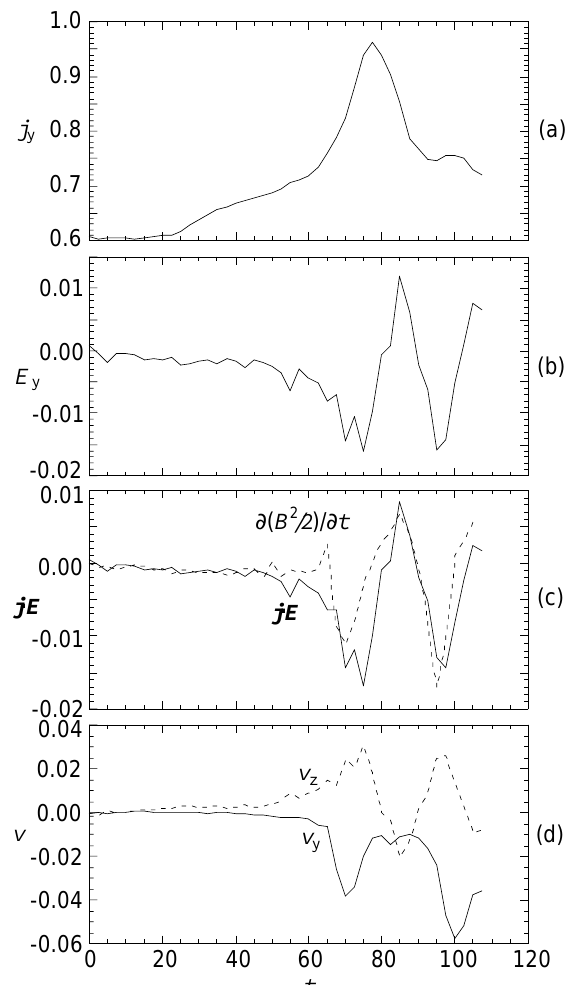
Fig. 9. Characteristic quantities in the generator region at x =− 8 . 75 , y =− 4 , z = 1 . 2 as functions of time, (a) cross-tail cur- rent density, (b) cross-tail electric field, (c) j · E (solid line) and the local derivative of the magnetic energy density, ∂(B 2 / 2 )/∂t (dashed line), and (d) the velocity components v y (solid line) and v z (dashed